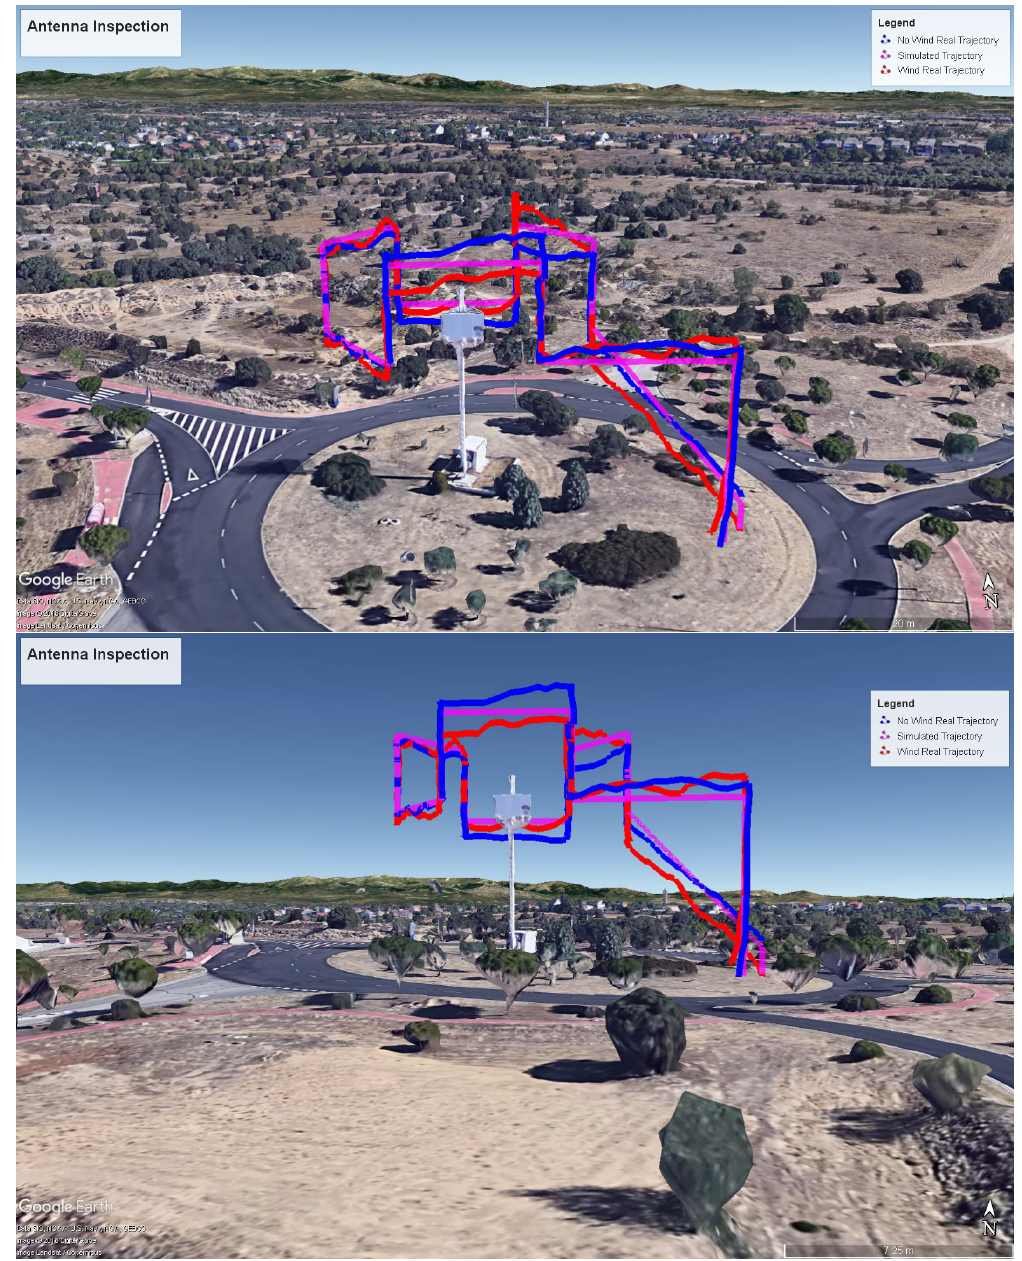
Figure 15. Two different perspectives of real (little wind, windy conditions) and MDS predicted/ simulated 3D